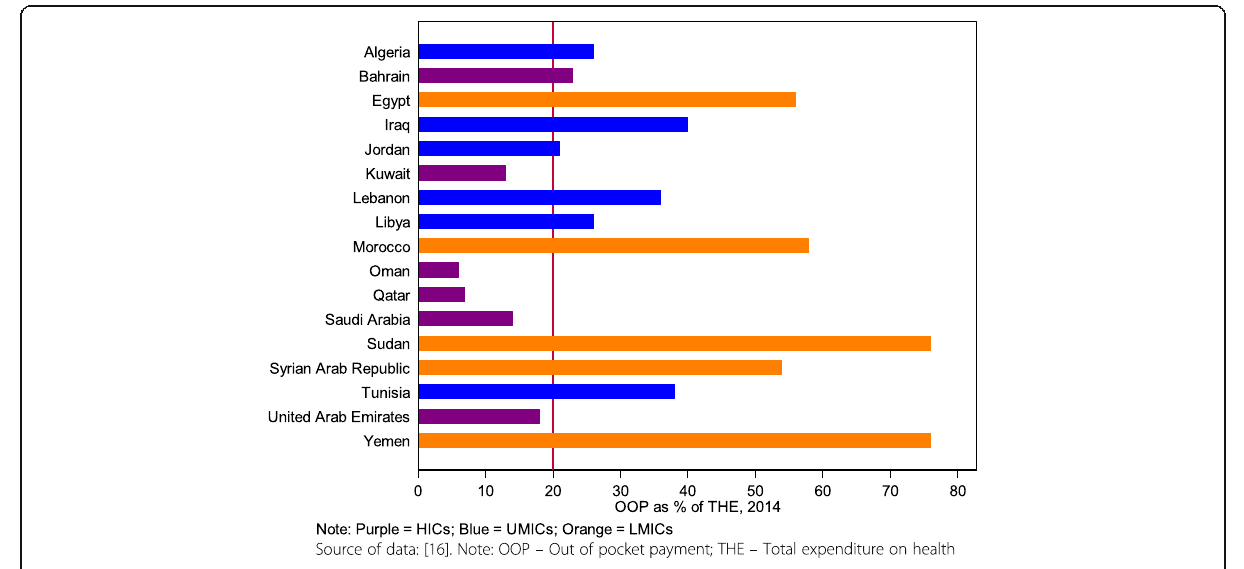
Fig. 6 Out of pocket payment as a percentage of total health expenditure, 2014, by